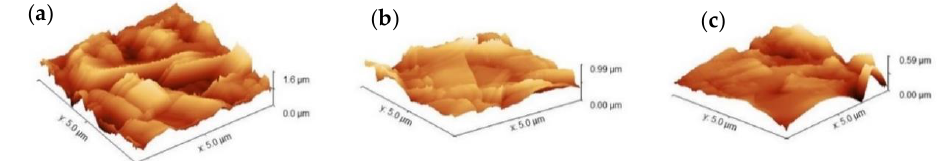
Figure 9. Topographical images produced by AFM of samples coated ( a ) in formulation 8 for 120 min, ( b ) formulation 14 for 120 min and ( c ) formulation 14 for 360 min.